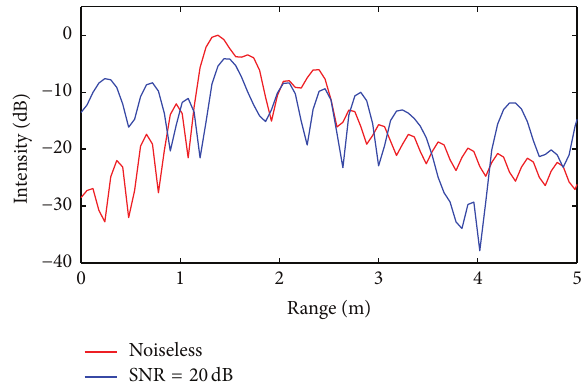
Figure 10: Range profile obtained from CS procedure (comparison between noiseless and Gaussian corrupted case, first scenario: 4 targets): only the second target is missed in the presence of noise (SNR = 20 dB).